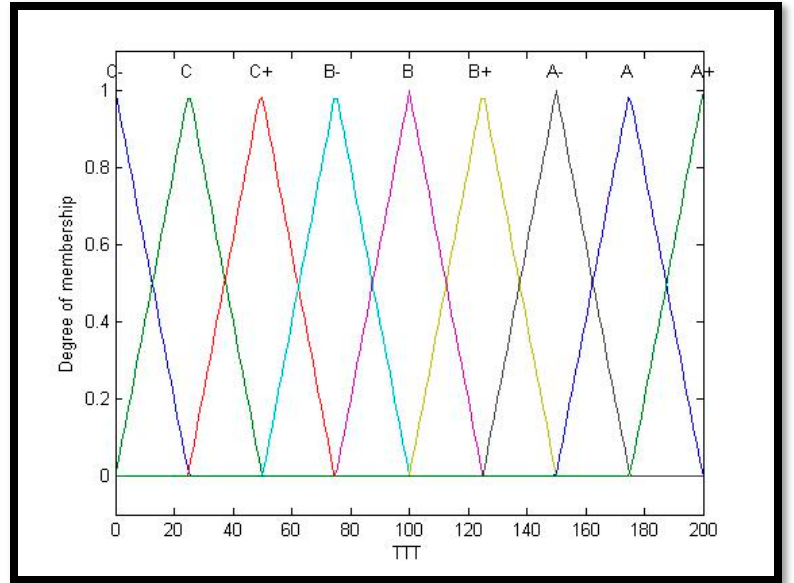
Figure 8. Membership function of linguistic HOM.